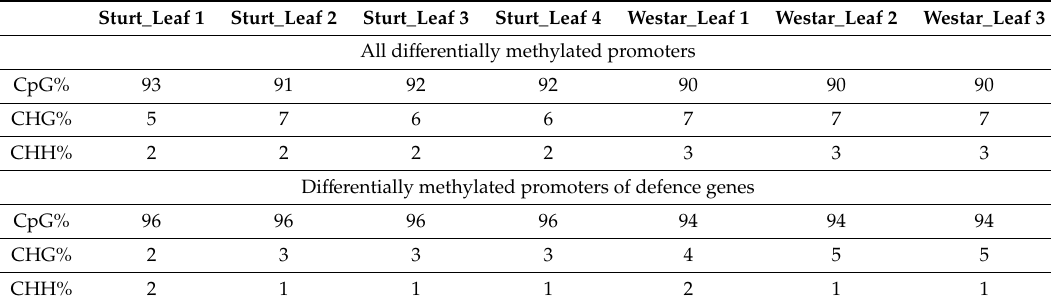
Table 1. The context percent of the di ff erentially methylated bases between leaves from control plants and leaves from plants infected with Leptosphaeria maculans of B. napus cultivars Westar (susceptible) and Sturt (resistant) among all di ff erentially methylated promoters and di ff erentially methylated promoters of defence